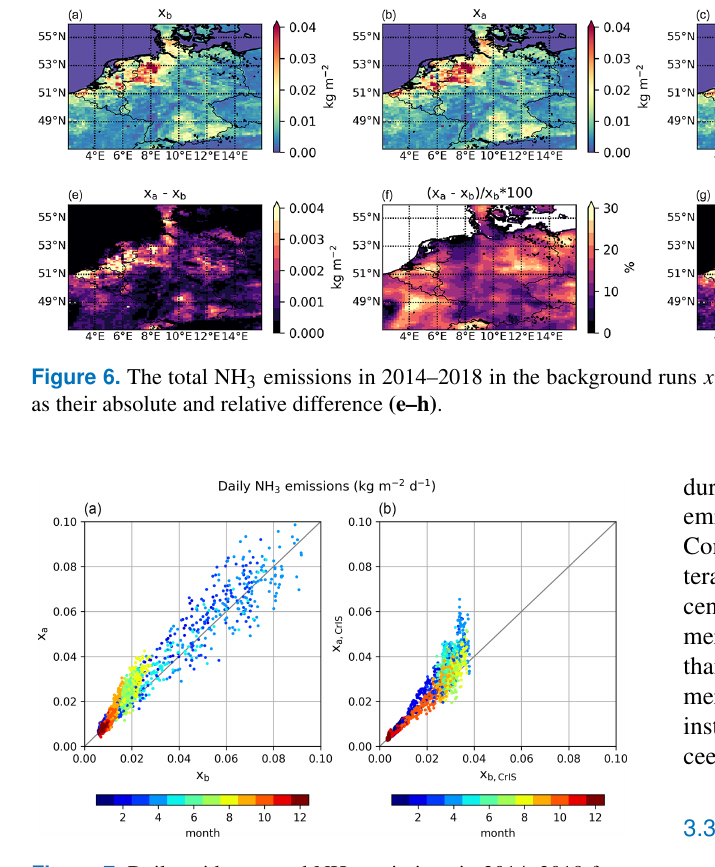
Figure 7. Daily grid-averaged NH 3 emissions in 2014–2018 from the (a) default background run ( x b ) versus analysis run ( x a ) and from the (b) background run with the CrIS-based NH 3 time factors ( x b , CrIS ) versus analysis run x a , CrIS , colored per